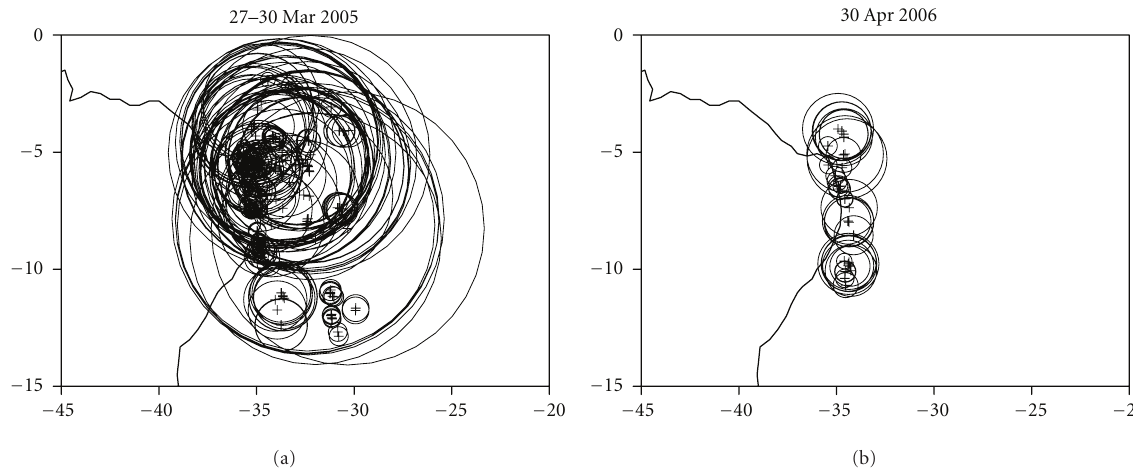
Figure 6: Two examples (27–30 March 2005 (a) and 30 April 2006 (b)) at 30-minute interval of the spreading behaviors of MCSs (represented as circles with proportional area and centers of mass as crosses) that were associated with the two corresponding strong rainy selected events (see Table 1 and Figure